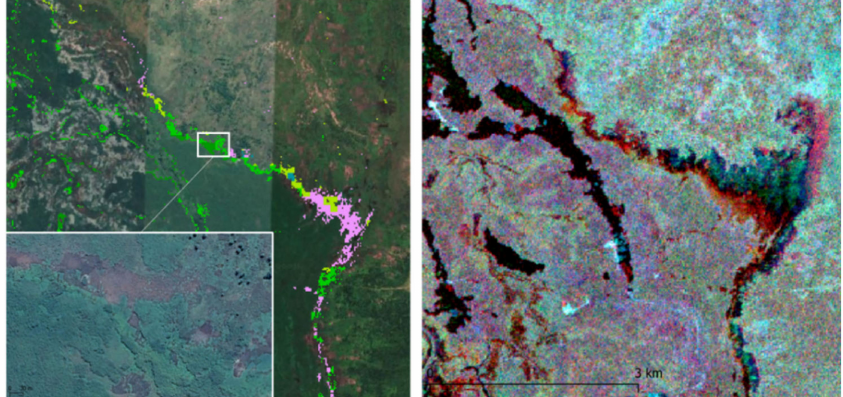
Figure 13. Detail area ( a ) in Figure 10. Left: pixels corresponding to cluster 3, colored according to the underlying CORINE class; inset shows a particular area corresponding to a forest glade; background from Google Earth TM imagery. Right: same area, extracted from the RGB change image in Figure